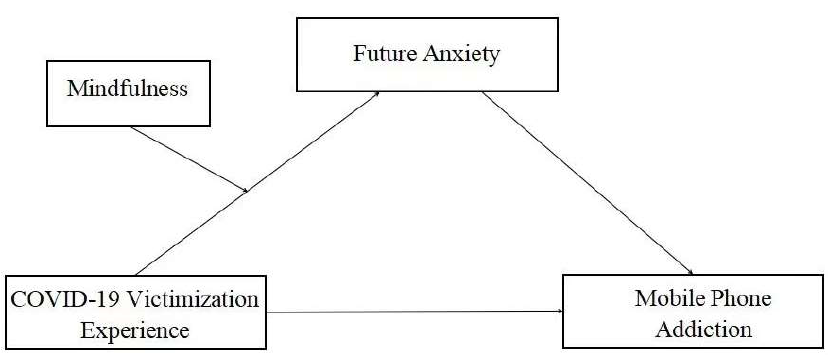
Figure 1. Moderated mediation model.